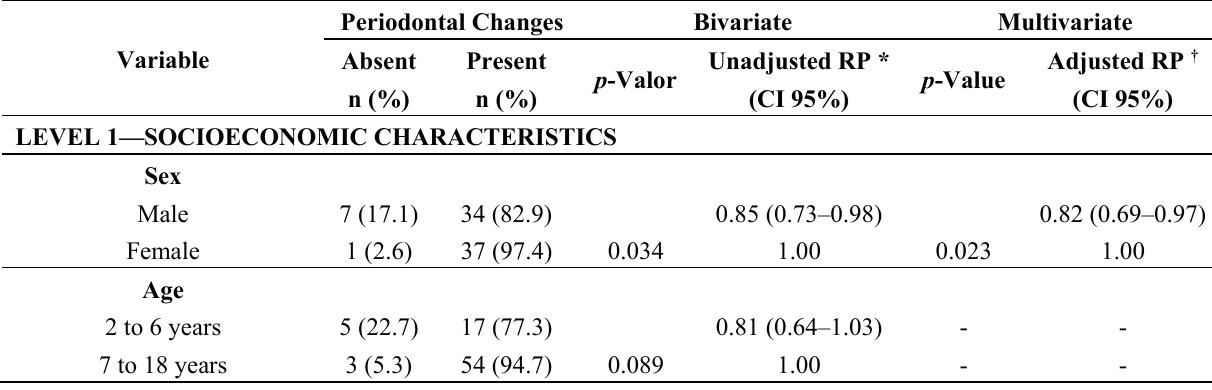
Table 6. Distribution of children and adolescents with CP in Poisson regression bivariate and multivariate models for the presence of periodontal changes and independent